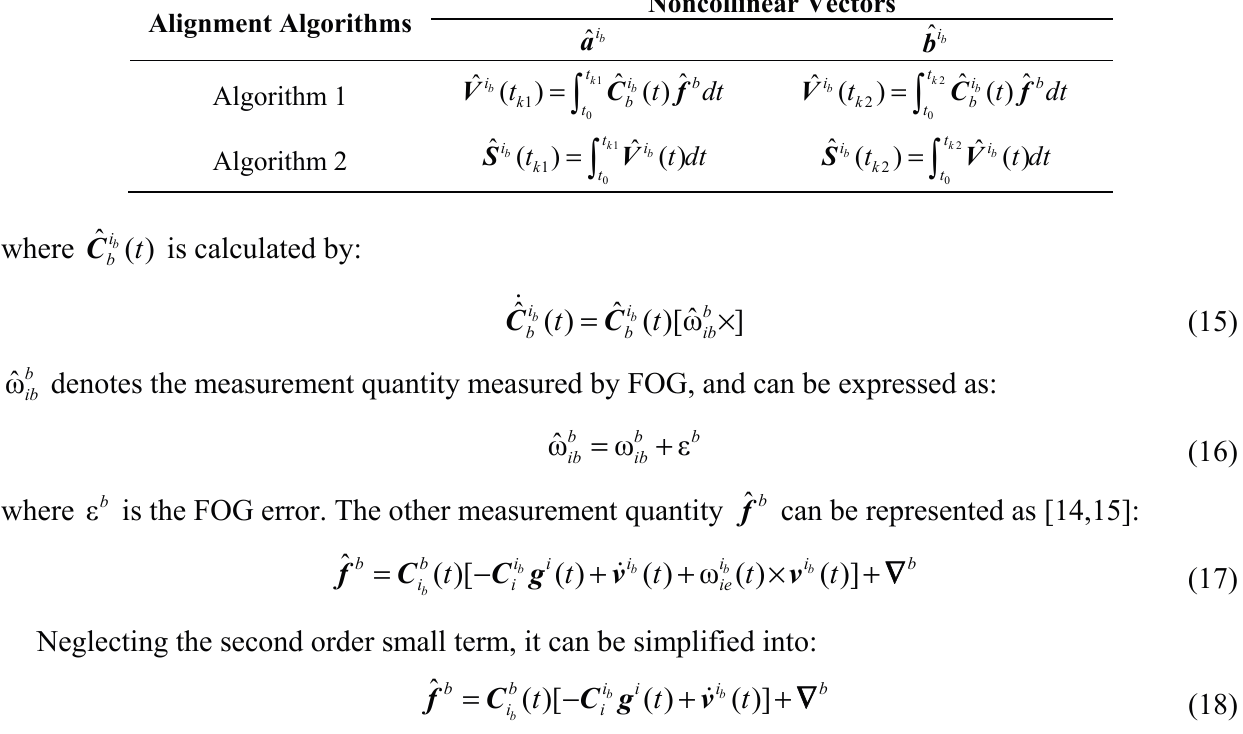
Table 3. Computed noncollinear vectors in body inertial frame Alignment